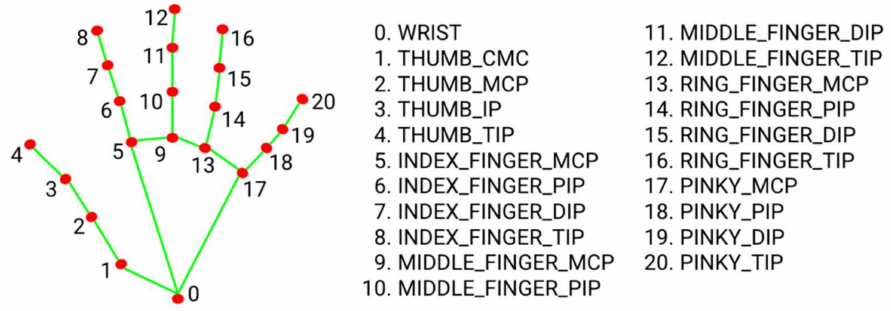
Figure 4. MediaPipe hand landmarks [46].